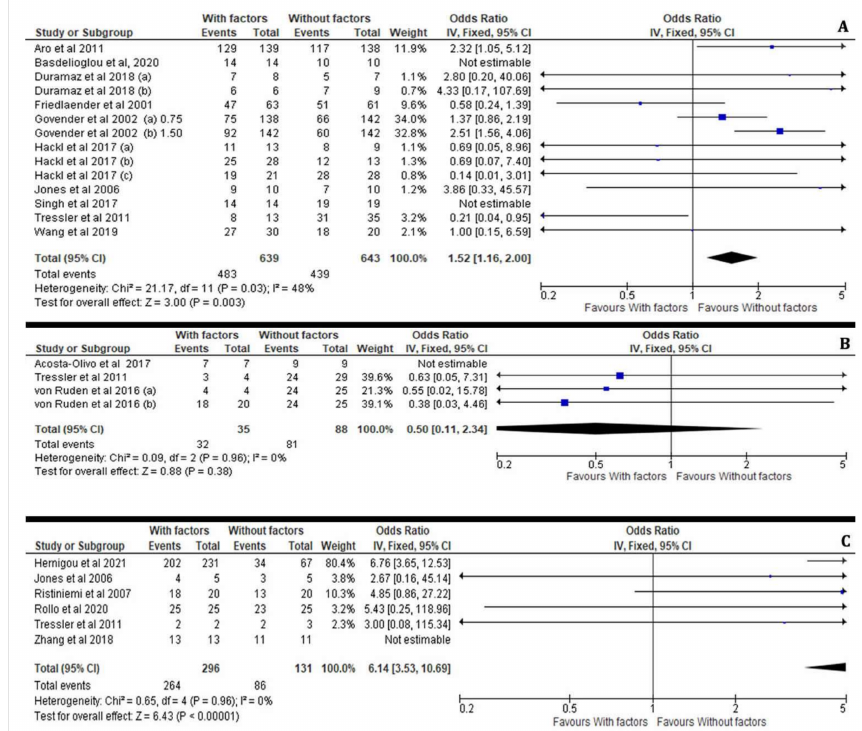
Figure 10. Forest plots presenting the effectiveness of osteoinductive factors in the bone